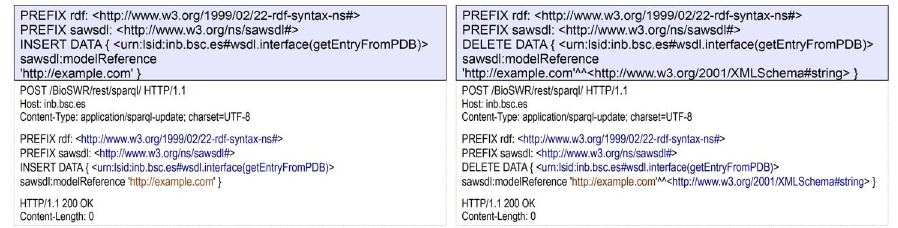
Figure 3. Add/Remove SAWSDL reference via SPARQL UPDATE query.